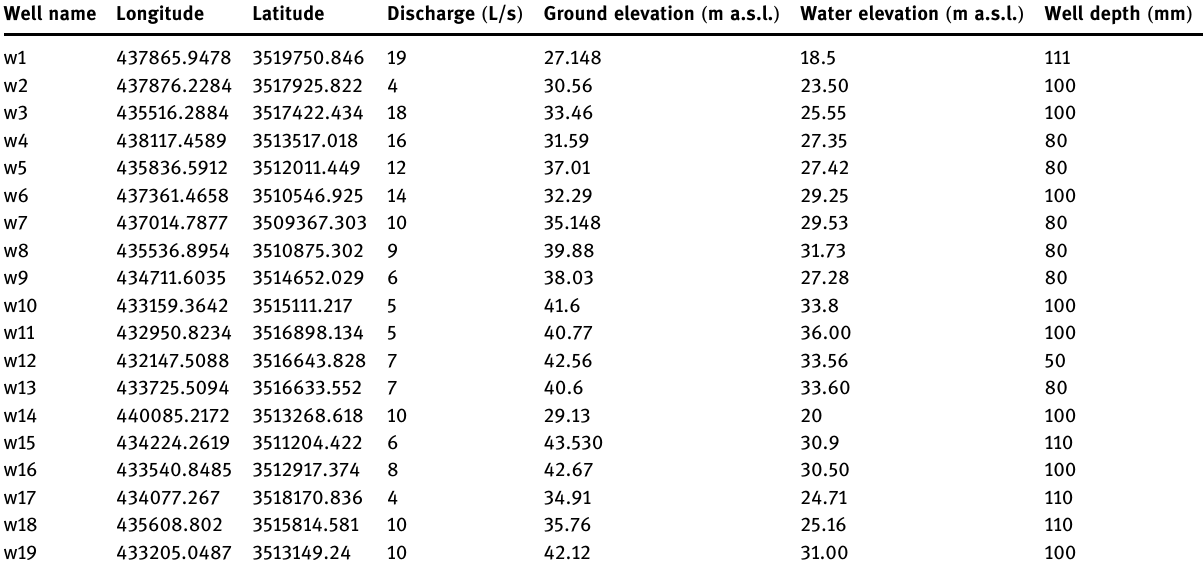
Table 2: Data of the